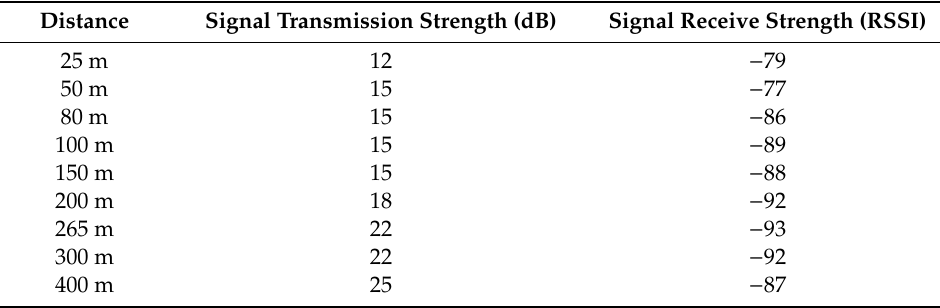
Table 3. Communication distance test of 802.11p module.